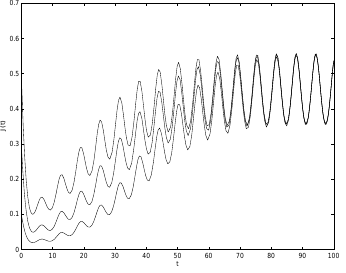
Figure 1. Trajectories of S(t) for dif- ferent initial conditions.